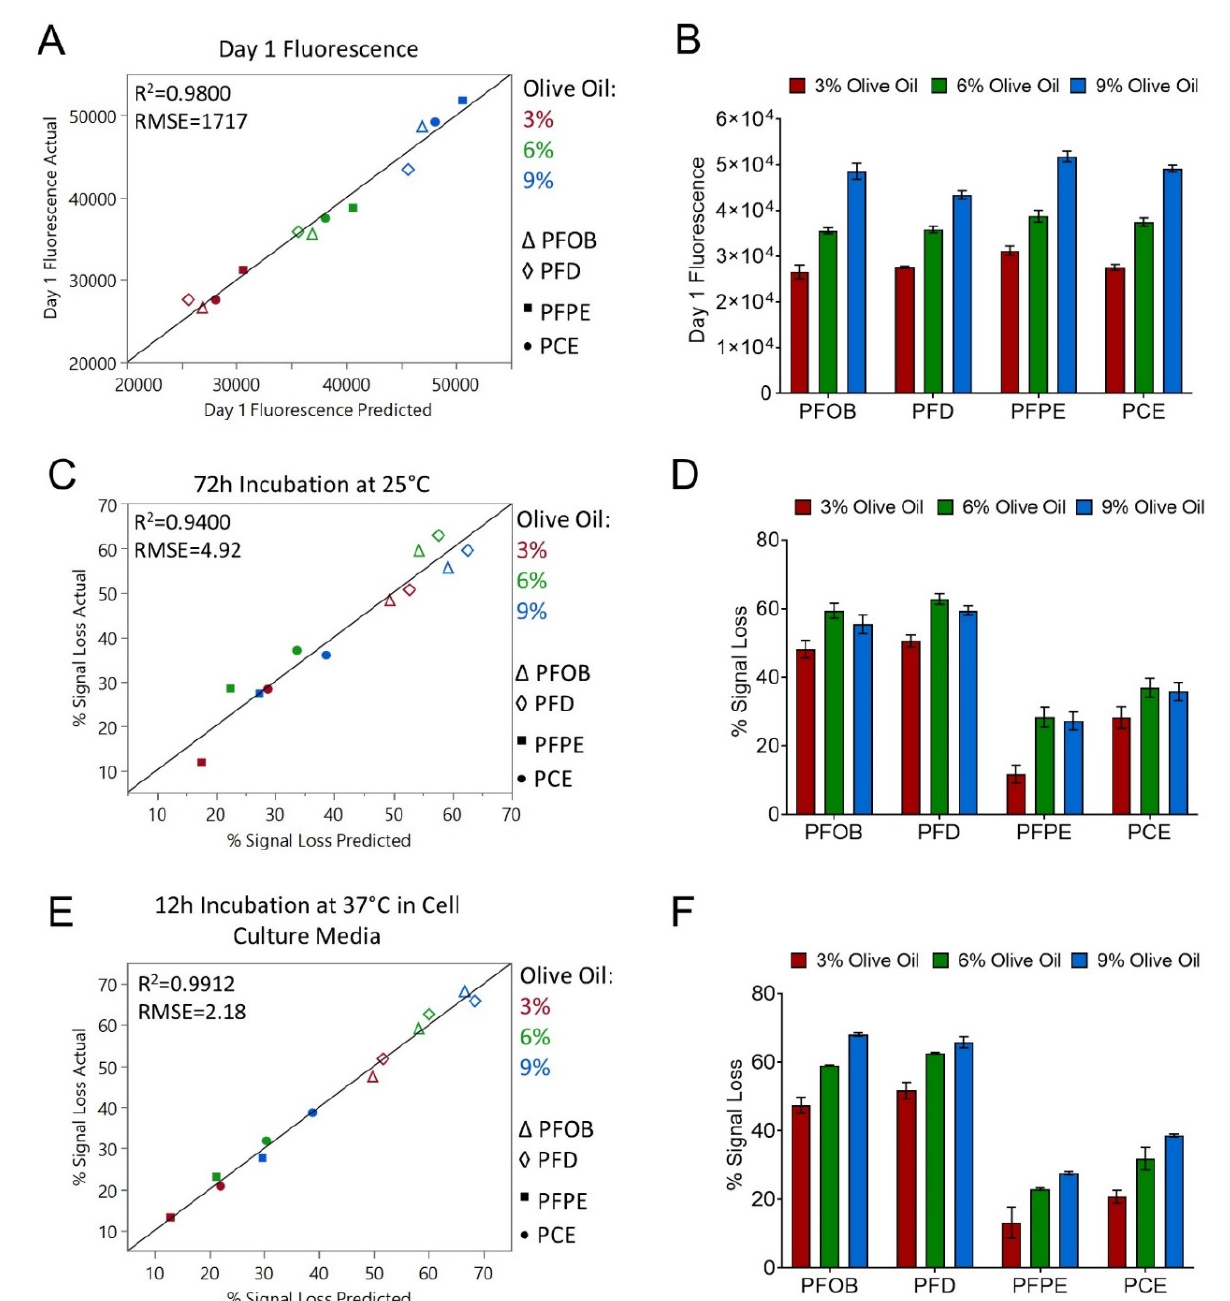
Figure 2. MLR models were developed to predict ( A , B ) baseline fluorescence (24 h after production) and percent fluorescence signal loss after ( C , D ) 72 h incubation at 25 °C and ( E , F ) 12 h incubation in cell culture media at 37 °C.